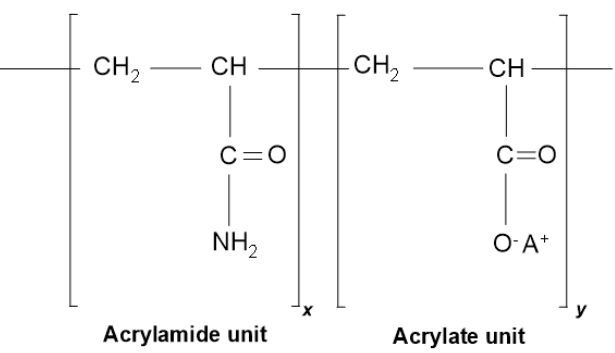
Figure 1. Chemical structure of PHPA.